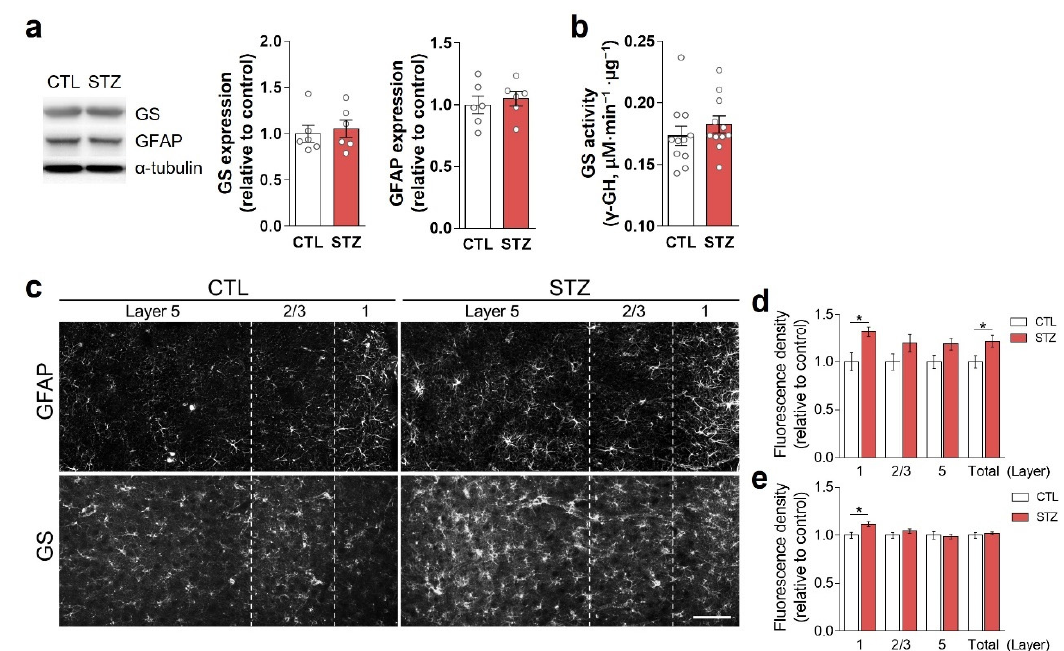
Figure 3. Hyperglycemia-induced astrocytic alterations in the medial prefrontal cortex (mPFC). ( a ) Western blot analysis of glutamine synthetase (GS) and glial fibrillary acidic protein (GFAP) using PFC crude lysates. The left panel shows representative immunoblot images, and the right panel shows quantifications. ( b ) GS activity in the PFC crude lysates. ( c – e ) Immunohistochemical analysis of GFAP ( c , d ) and GS ( c , e ) in the infralimbic mPFC. Scale bar = 50 μ m. Data are presented as mean ± SEM. * p < 0.05 between indicated groups according to Student’s t -test. n = 6/group.